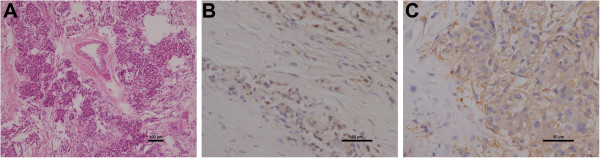
Histological and immunohistochemical analyses of the retroperitoneal paraganglioma. (A) Hematoxylin and eosin staining of the resected specimen (magnification, 100×; scale bar = 100 μm). (B and C) Immunohistochemical staining for (B) S100 protein and (C) synaptophysin (magnification, 400×; scale bar = 50 μm).